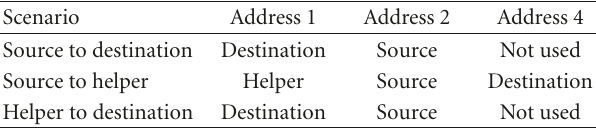
Table 1: Addressing scheme for di ff erent